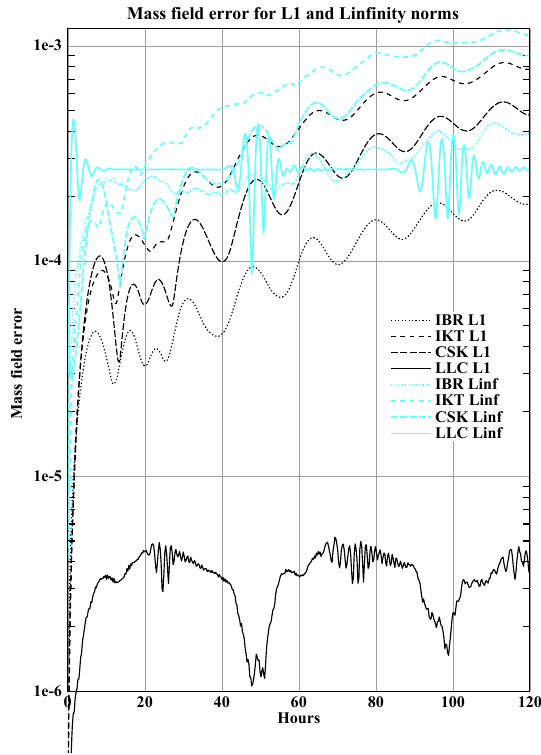
Figure 5. Mass field errors l 1 and l ∞ as function of time for solid body rotation initial conditions without bottom topography. Models represented are IBR, IKT, CSK, and LLC at 2 ◦ resolution.